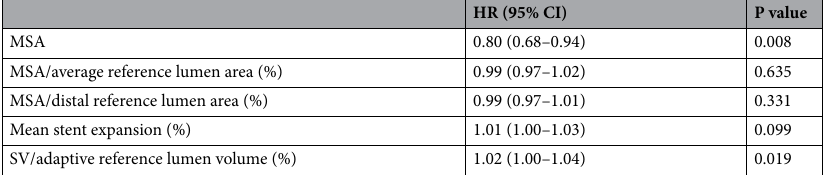
Table 4. Association between stent expansion indices and DoCE. CI confidence interval, DoCE device- oriented clinical end point, HR hazard ratio, MSA minimal stent area, SV stent volume.